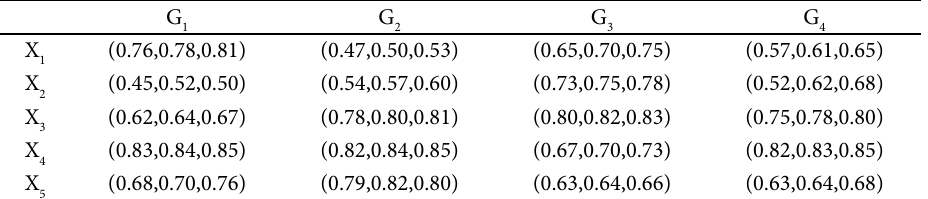
Table 2. Decision